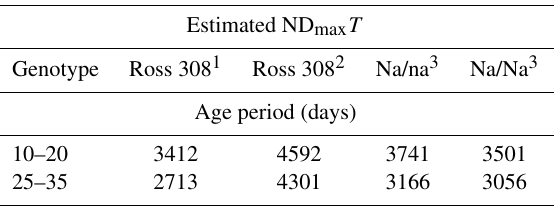
) − 1 day − 1 ] of Table 2. Age-dependent ND max T [mgN(BW 0 . 67 kg male meat-type chicken genotypes.